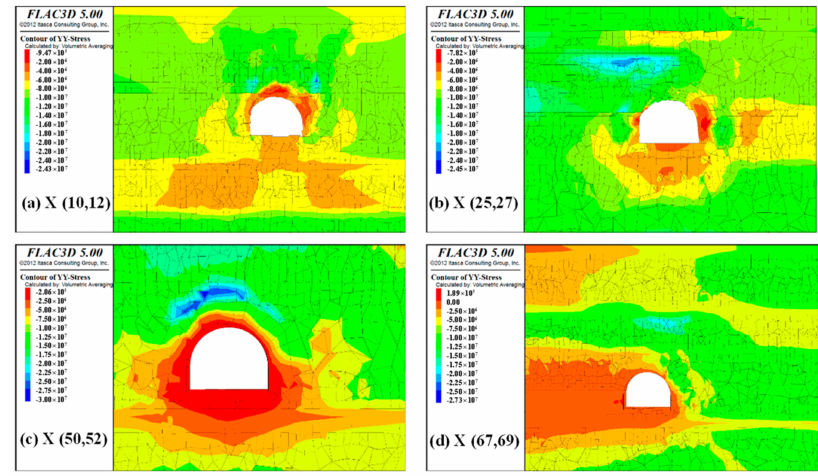
Figure 14. Y − direction stress distribution of the four monitoring areas after excavation of electrome- chanical